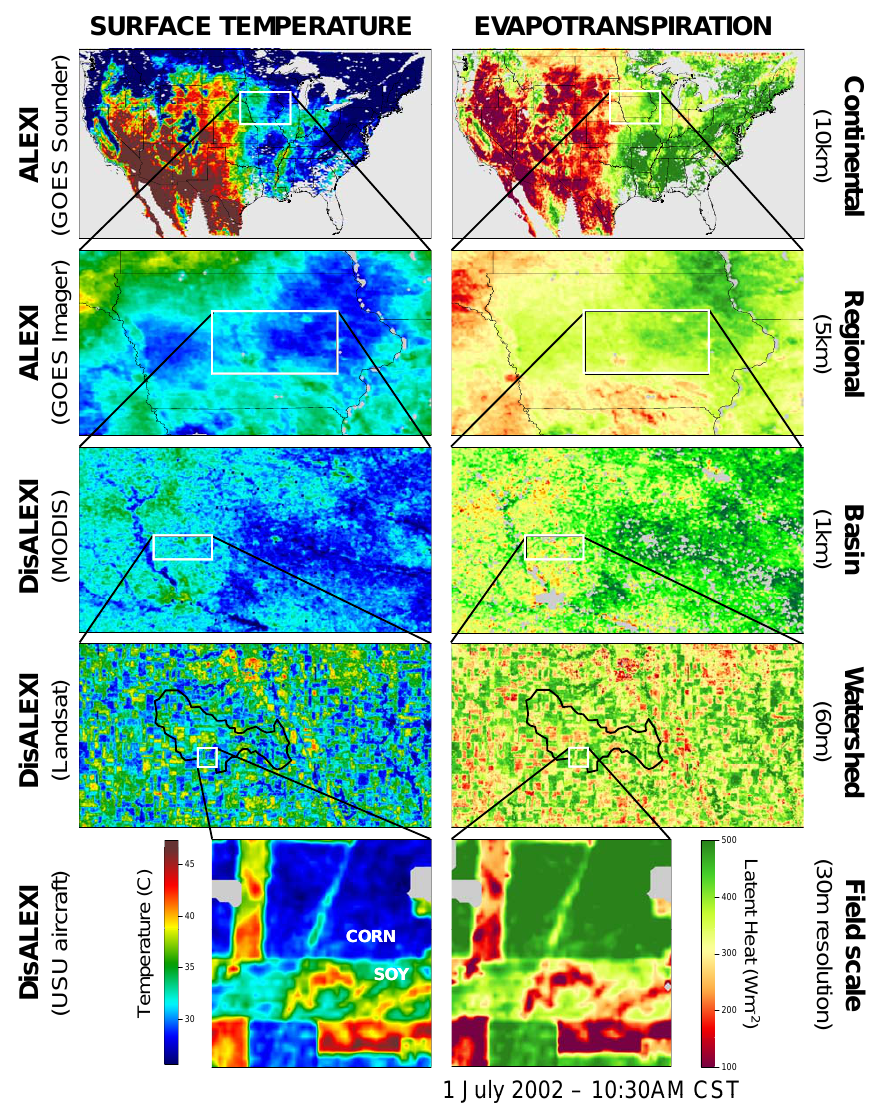
Fig. 2. Multi-scale ET maps for 1 July 2002 produced with ALEXI/DisALEXI using surface temperature data from aircraft (30-m resolution), Landsat (60-m), MODIS (1-km), GOES Imager (5-km) and GOES Sounder (10-km), zooming into the Walnut Creek Watershed near Ames, Iowa, site of the SMEX02 Soil Moisture Experiment. The continental-scale ET map is a 14-day composite of clear-sky model estimates (figure from Anderson and Kustas,